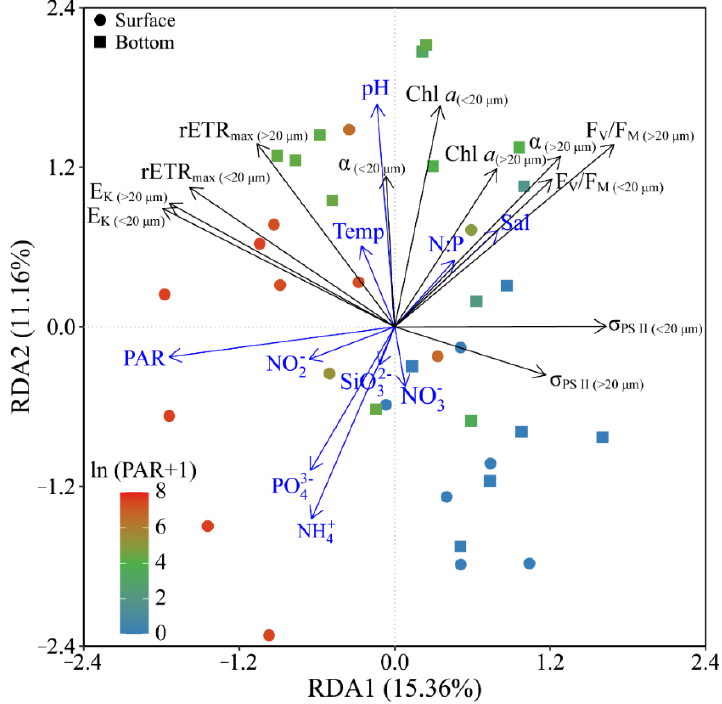
Figure 7. Redundancy analysis (RDA) for correlation of pooled photosynthetic parameters and environmental variables for piconano- (<20 µm) and micro-cell assemblies (>20 µm). Constrained axes RDA1 and RDA2 account for 15.36% and 11.16% of total variance, respectively. The color in the symbol indicates the ln(PAR + 1) wherein the PAR is the cell-received irradiance in field condition. Temp, temperature; Sal, salinity.